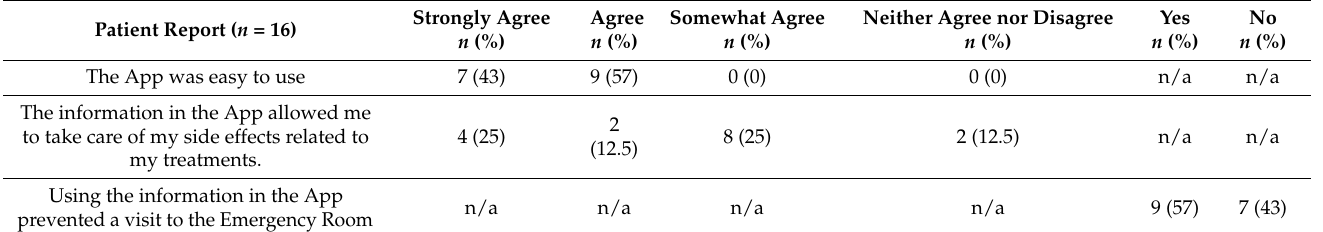
Table 3. Overview of patient provider quality improvement feedback on experience using platform.